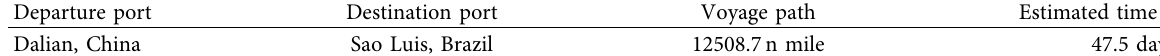
Table 5: Detailed sailing route information of the target ship.